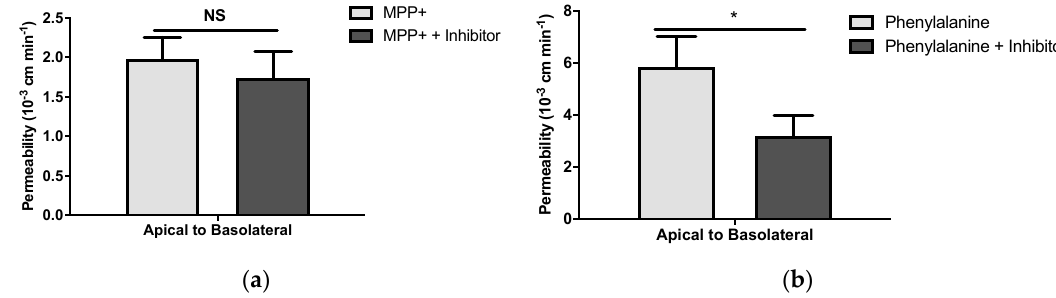
Figure 4. Permeability (10 -3 cm min -1 ) from apical to basolateral passage of ( a ) [ 3 H]-MPP + ± tetraethylammonium (TEA) 2 mM or ( b ) of [ 3 H]-Phenylalanine ± Inhibitor (Tryptophan 5 mM) on a human blood-brain barrier (BBB) model, corrected to that of [ 14 C]-sucrose transport (PE; 10 -3 cm min - 1 ). Results are expressed as mean ± S.D. (n = 3–4 independent experiments, performed in triplicate). NS: no statistical significance, * p < 0.05 in the presence vs lack of the adequate inhibitor.